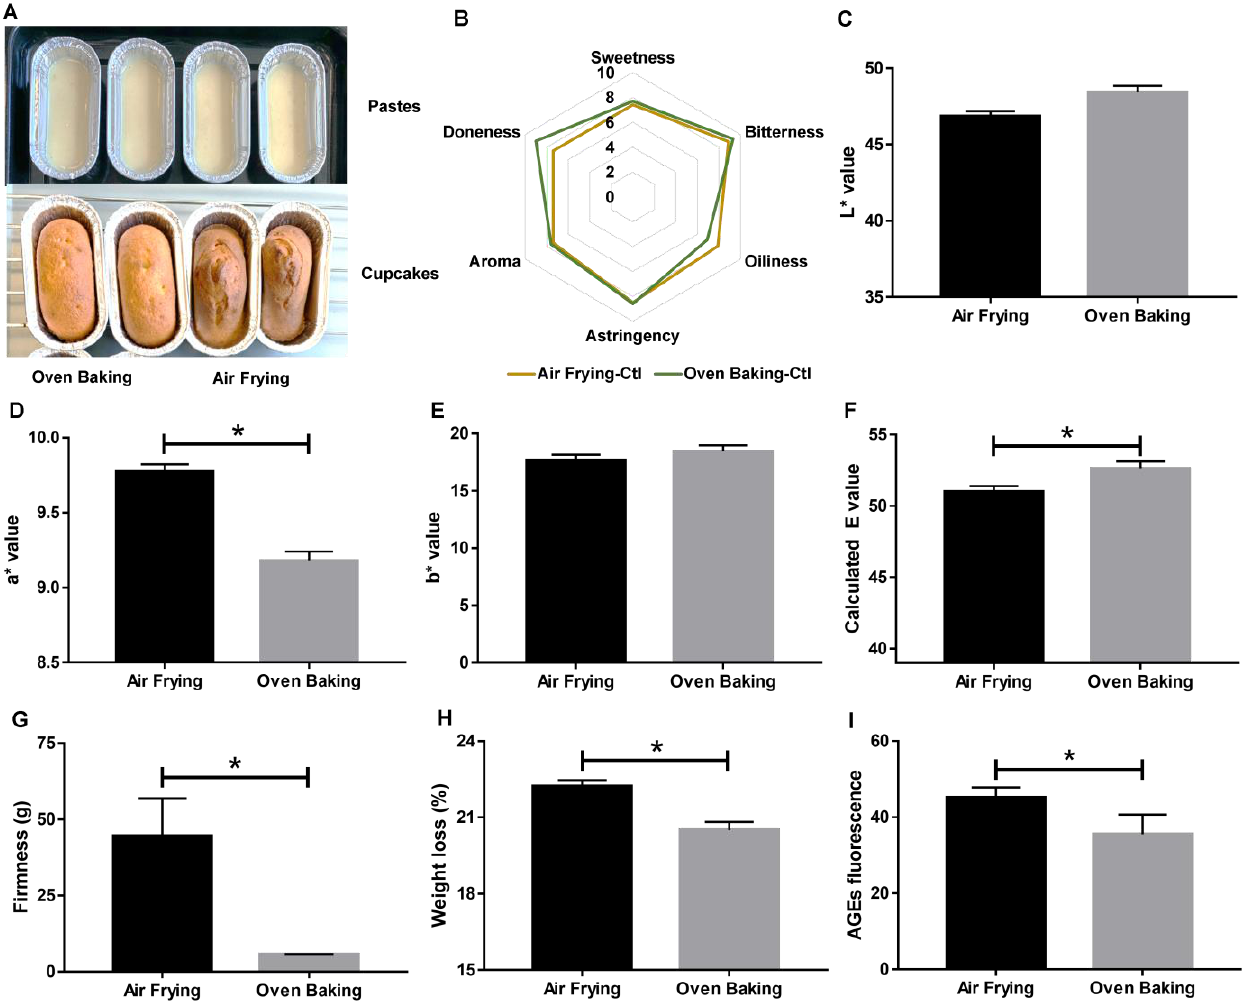
Figure 1. Characteristic comparisons between air-fried and oven-baked cupcakes. ( A ) Represented picture of cupcakes. ( B ) Radar chat of sensory evaluation. ( C – E ) Lab value. ( F ) Calculated E value. ( G ) Firmness. ( H ) Weight loss. ( I ) AGE fluorescence. * p < 0.05.